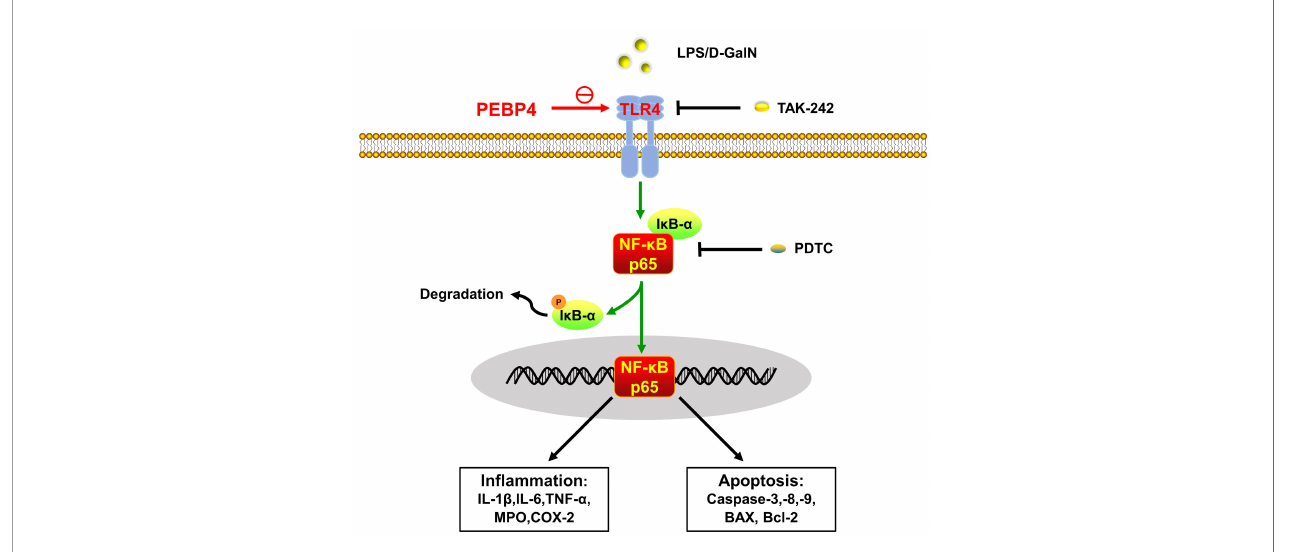
FIGURE 5 | Schematic of PEBP4-driven TLR4/NF- k B signaling pathway-associated in fl ammatory and apoptotic talk in LPS/D-GalN-induced ALI. PEBP4 CKO could activate the TLR4/NF- k B signaling pathway, promote NF- k B translocation into the nucleus, and then regulate the transcription of in fl ammatory factors and apoptotic genes to mediate acute liver injury (ALI) from both in fl ammation and apoptosis. TLR4 inhibitor (TAK-242) and NF- k B inhibitor (PDTC) could partially reverse these